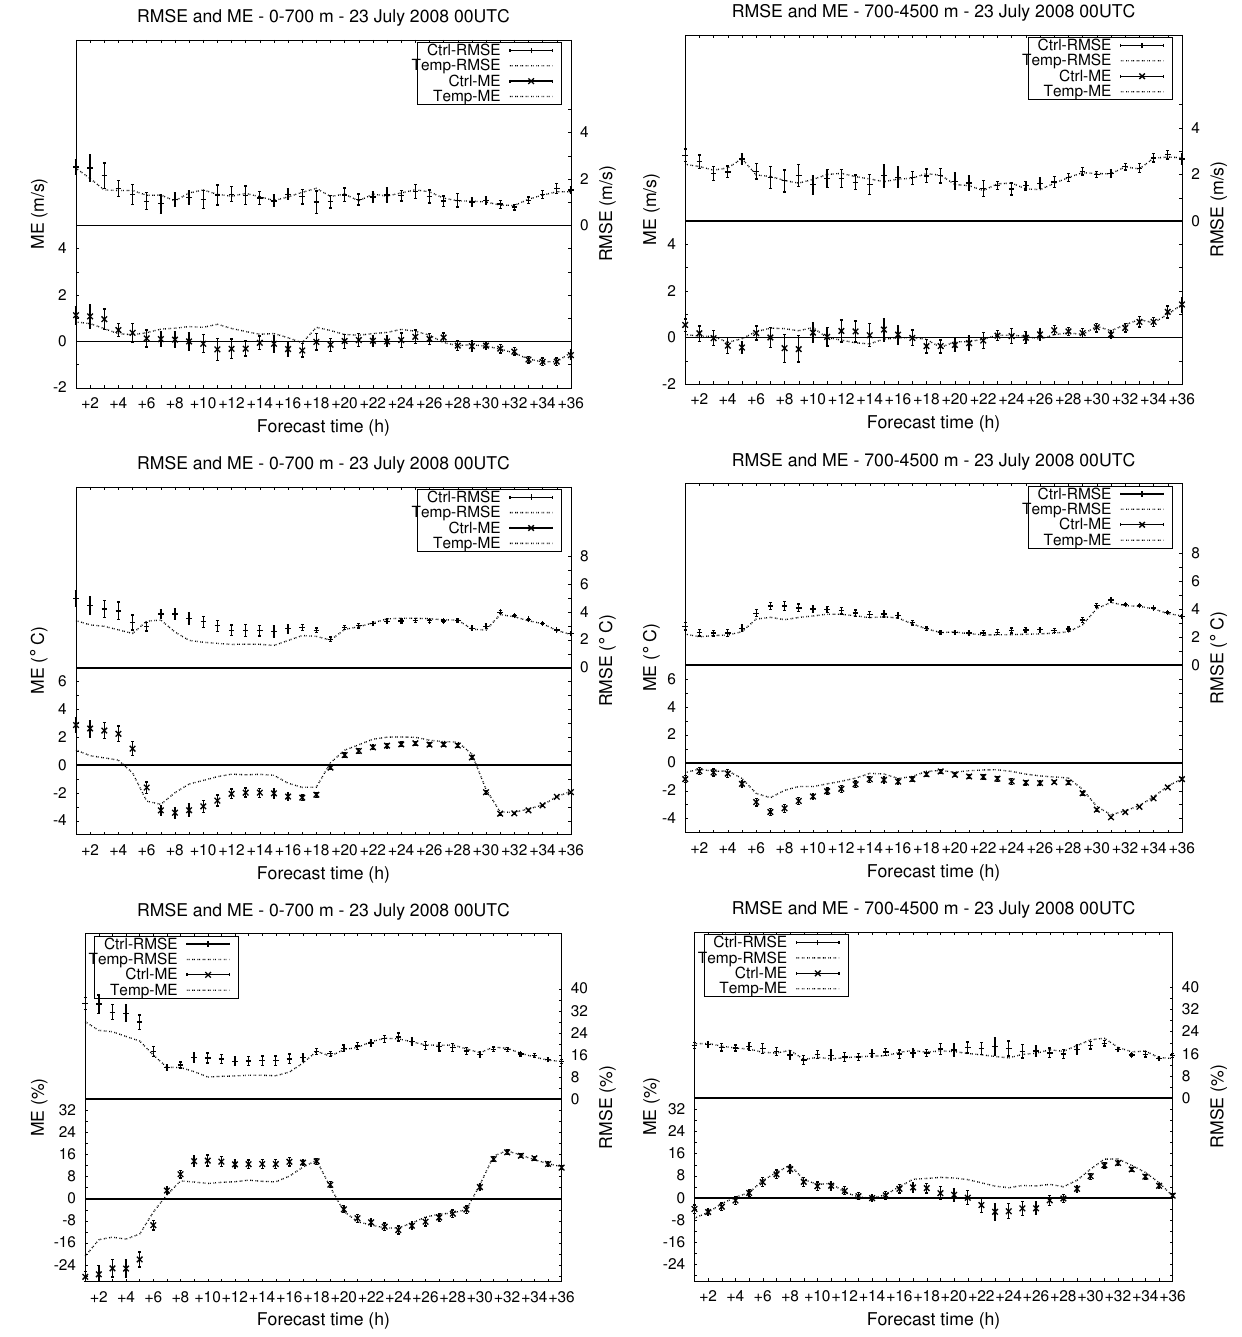
Fig. 11. RMSE and ME for the July 2008 case, over the plains (left) and over the mountains (right); wind intensity (upper panels), temperature (middle panels) and relative humidity (bottom panels). The dots represent the Ctrl run with the significance bar and the dotted line represents the Temp run.